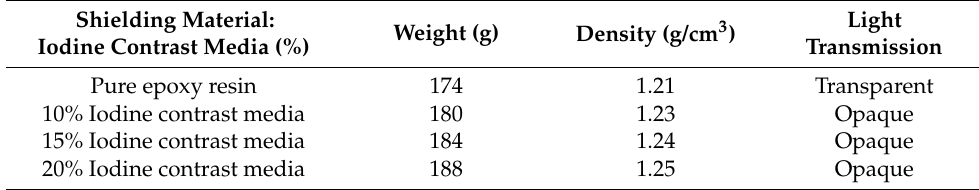
Table 2. The characterization of the